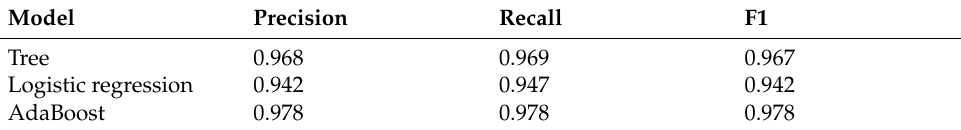
Table 4. Results of cross-validation with small- and large-scale